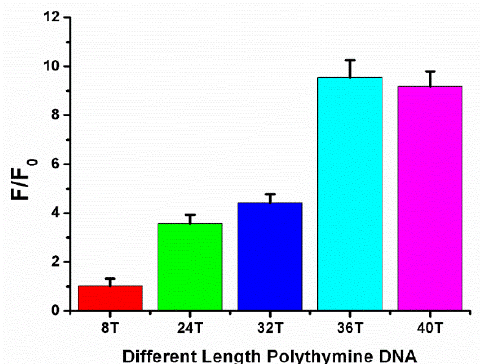
Figure 2. The fluorescence signal change (F/F 0 ) under different length polythmine DNA. where F 0 and F were the area under curve of the emission spectra in the absence and presence of 500 µM melamine, respectively. Error bars were estimated from at least three independent measurements.